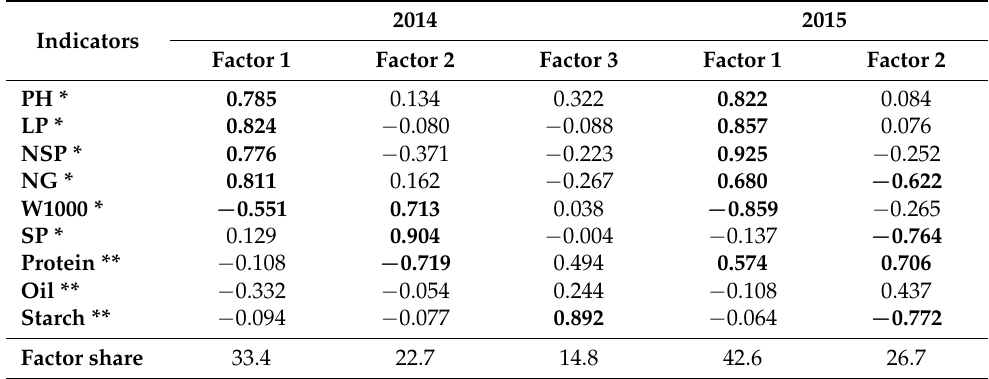
Table 4. Factor structure for the characters of Avena L. accessions from the VIR collection in